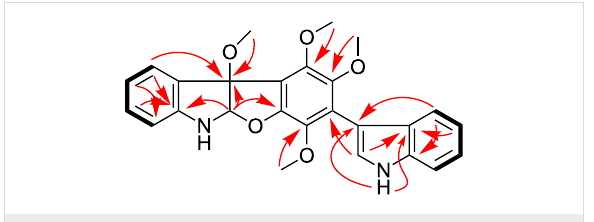
Figure 2: Key HMBC (arrows) and COSY (bond lines) correlations of compound 1